Question: What does this figure show? Answer in one sentence.
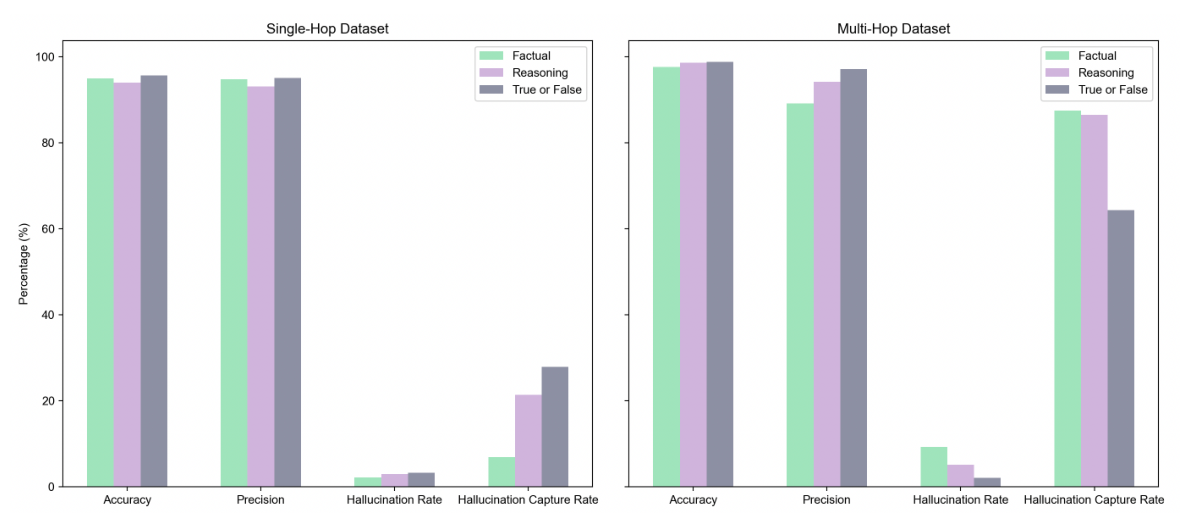
Answer: Performance assessment by question type for both the Single-hop and Multi-hop Q&A datasets. A  comparison of the performance of the LLM as evaluated based on the accuracy, precision, hallucination rate, and  hallucination capture rate for the single-hop dataset generation task (left) and the multi-hop dataset generation task  (right).